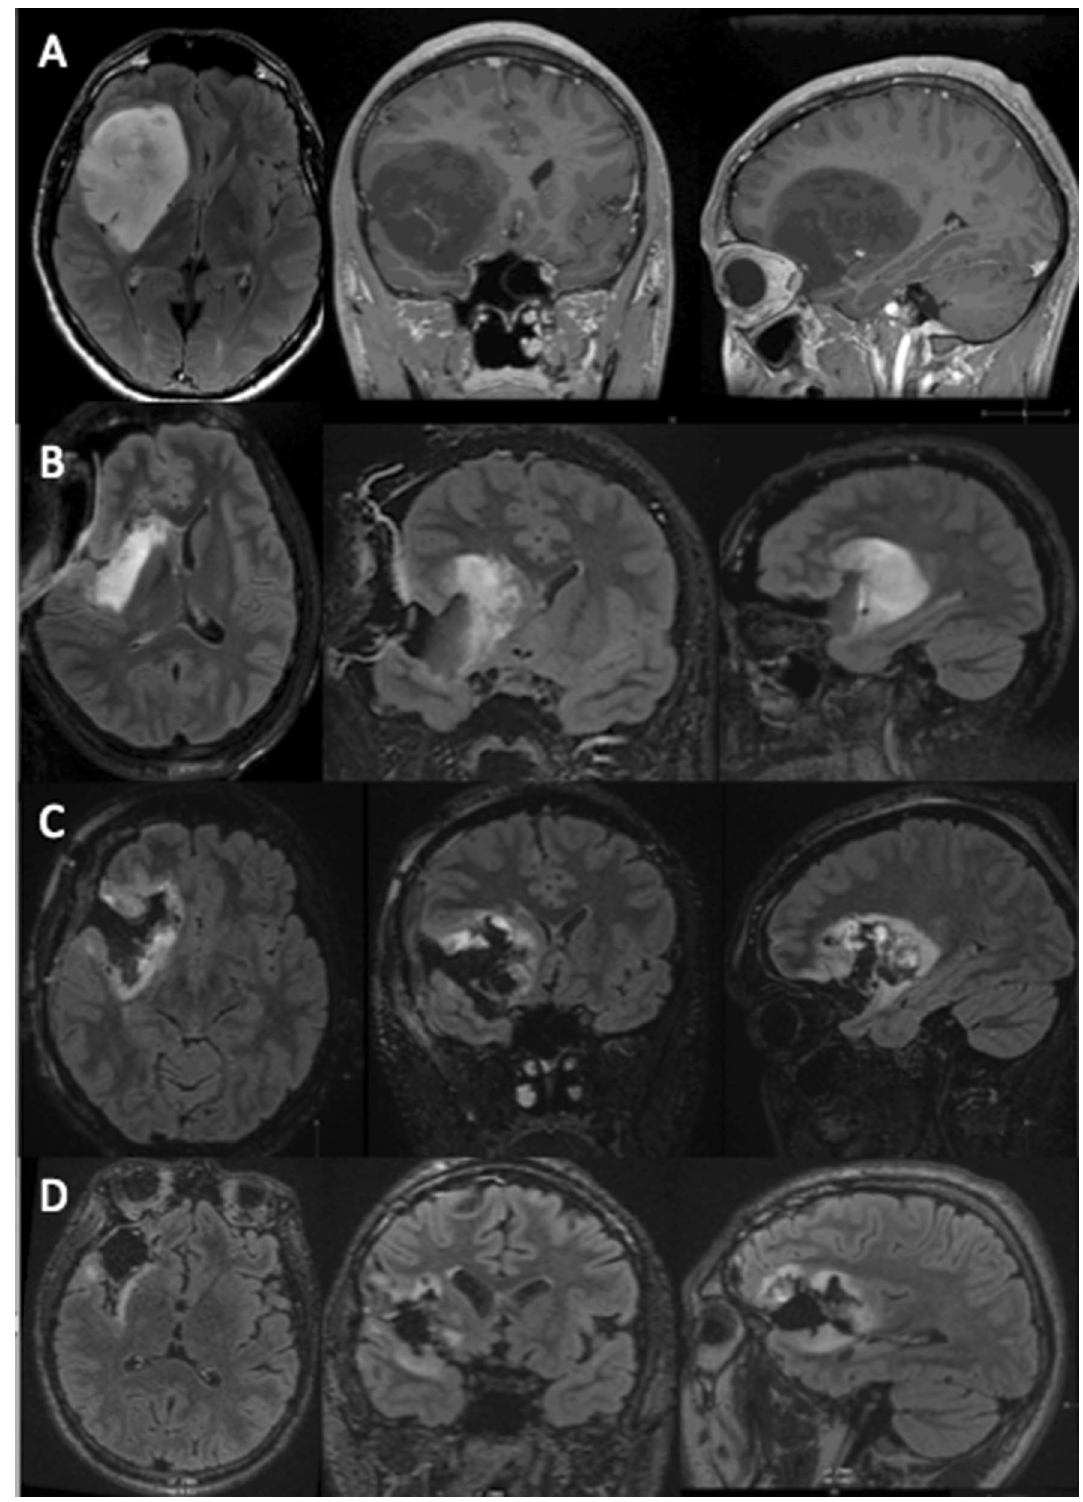
Figure 3. Staged surgical approach for a right fronto-temporo-insular glioma. ( A ) Preoperative MRI depicting a hypo signal T1 lesion, with sharp contours. The preoperative volume was of 112 cm 3 . ( B ) 1st IoMRI reporting a tumor remnant at the inner and posterior part of the insula and in the frontal lobe of 38 cm 3 . Additional resection was performed. ( C ) 2nd IoMRI, the tumor residue was of 11 cm 3 . Due to the presence of the internal capsule at the superior part of the lesion the end of surgery was decided. ( D ) Postoperative control at 3 months, with less perioperative signal abnormalities the residue was reassessed, with a volume of 6 cm 3 , corresponding to an EOR of 95% (using IntelliSpace Portal, Philips, module “tumor tracking.” version 9.0 (www. phili ps.